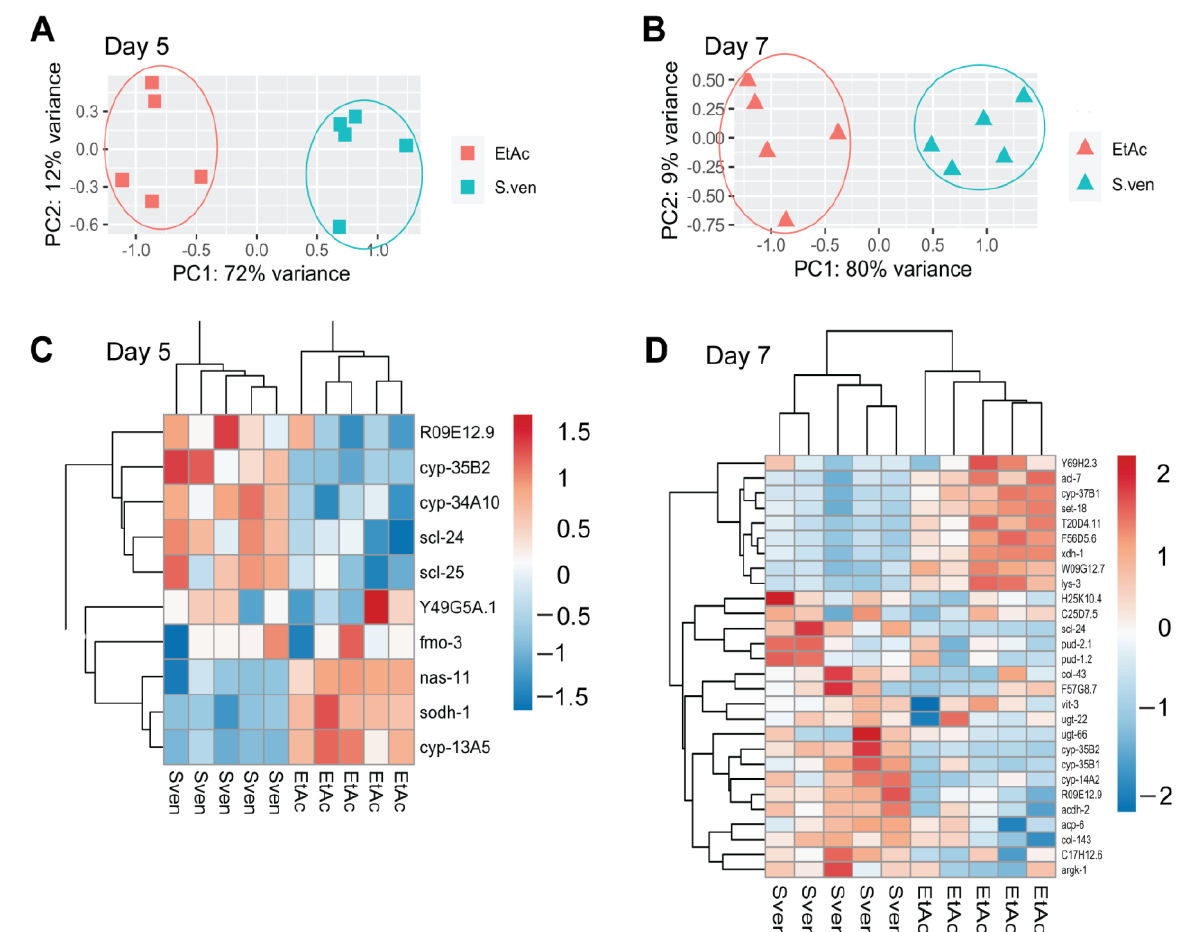
Figure 2. PCA plots and heatmaps of five replicates of differentially expressed genes as determined by the adjusted p -value. ( A , B ) Principal component analysis (PCA) showing relative distance among samples at day 5 ( A ) and day 7 ( B ). PC1 represents the variance between treatments, and PC2 represents the variance between replicates. Replicates from day 5 displayed a 72% variance between EtAc and the S. ven metabolite treatments, while the variance between replicates accounted for only 12% ( A ). Replicates from day 7 displayed an 80% variance between EtAc and S. ven metabolite treatments, while the variance between replicates accounted for only 9% ( B ). Red represents EtAc treatment, and blue represents S. ven treatment in ( A , B ). ( C , D ) Heatmap of Z-score normalized gene expression displaying significant DEGs at day 5 ( p adj < 0.054) ( C ) and day 7 ( p adj < 0.057) ( D ).